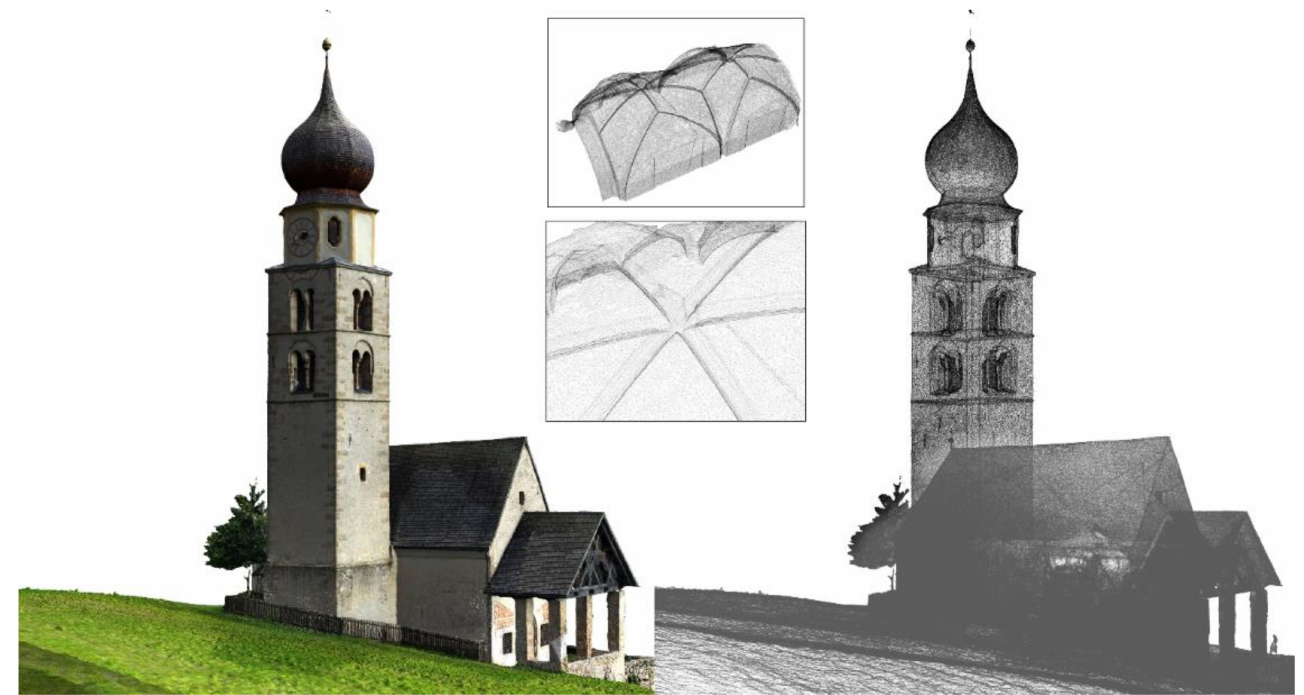
Figure 6. The mesh models of the church: the main outputs of digital photogrammetry cannot be considered informative models able to share different types of information. They are considered primary data sources as well as point clouds of the proposed method.